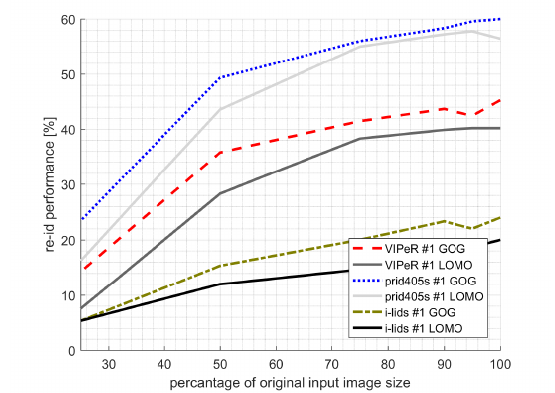
Figure 8. PRID rank#1 as function of the percentage image resolution. 100%, 95%, 90%, 75%, 50% and 25% are measured.